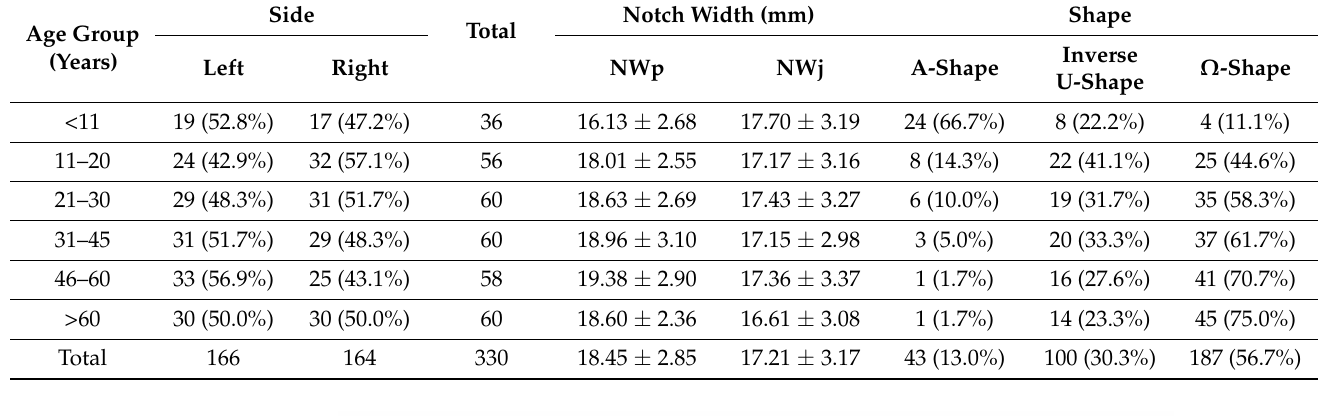
Table 1. Demographic information on study population.